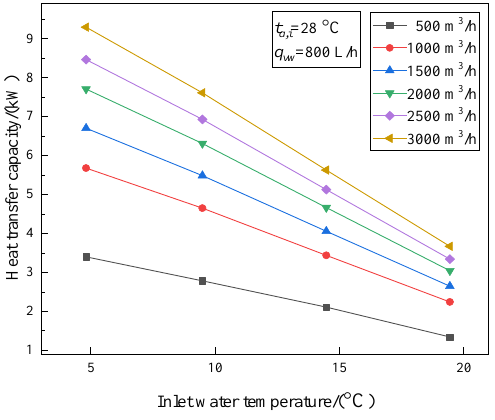
Figure 10. Variation of heat transfer rate under different air flow rates.